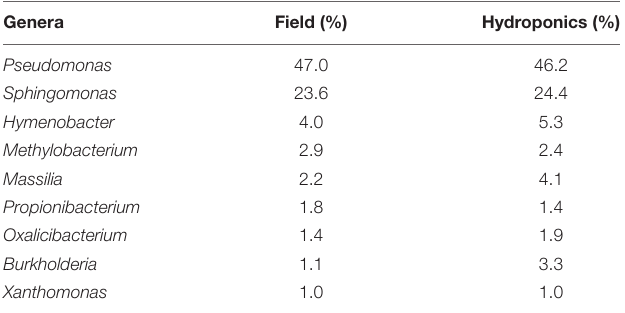
TABLE 3 | Mean relative abundance (%) in each group at the genus